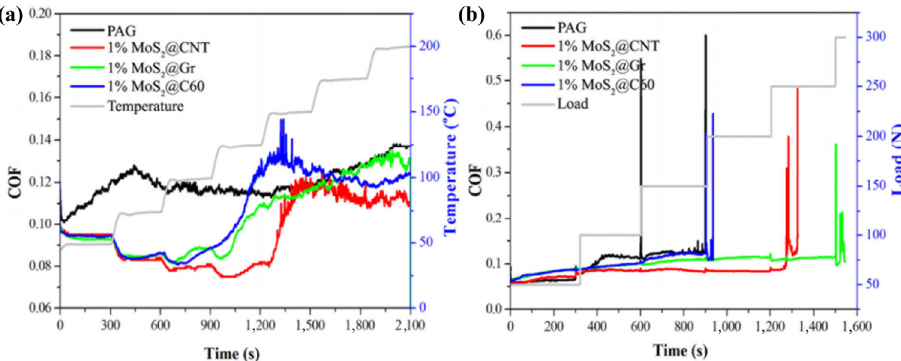
Fig. 7 COF of the steel discs lubricated by PAG base oil and PAG containing 1 wt% CNT, 1 wt% Gr, 1 wt% C60, 1 wt% MoS 2 , 1 wt% and (b) loads (temperature, 100 °C; stroke, 1 mm; and frequency, 25 Hz).